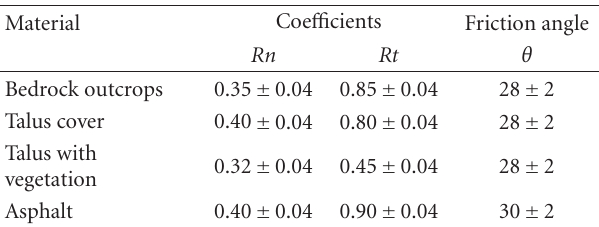
Table 1: Physical parameters used in the model.